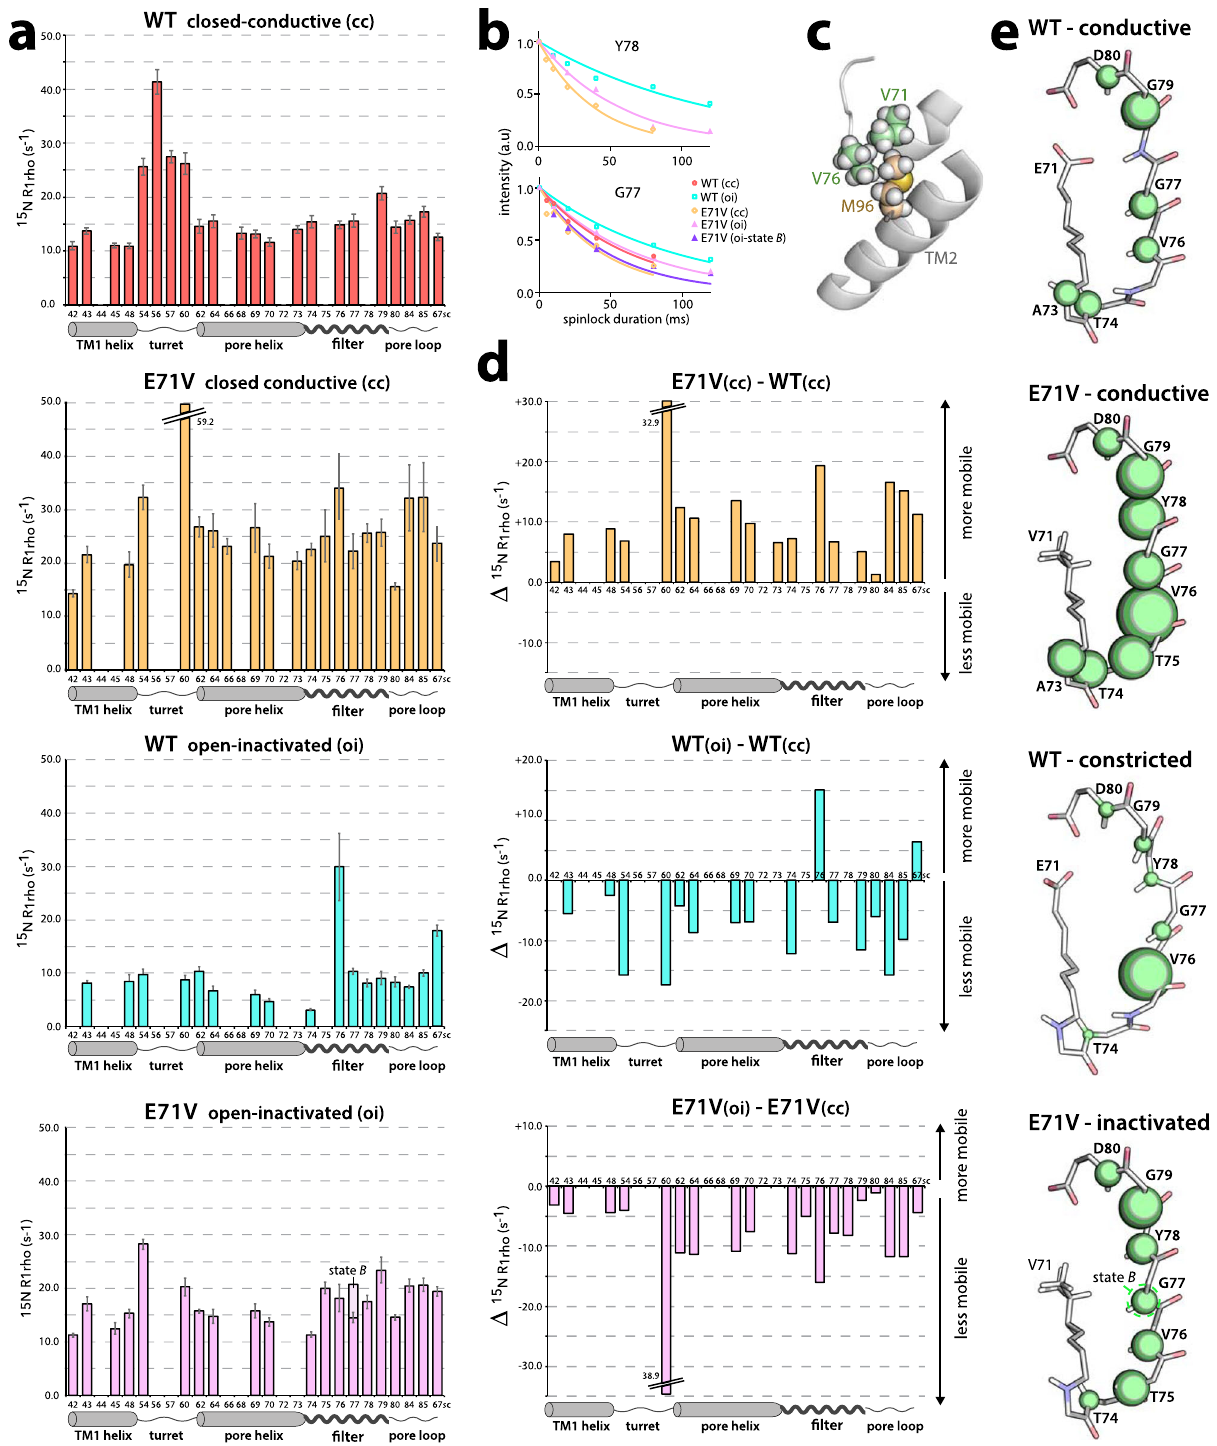
Fig. 6 Dynamics measurements in different gating modes. a 15 N rotating-frame ssNMR relaxation rates ( R 1rho ) that report on slow molecular motions in closed-conductive (cc) and open-inactivated (oi) WT KcsA (red, cyan) and E71V (yellow, pink), measured at 700 MHz and 60 kHz MAS. The error bars show the standard error of the fi t. Source data are provided as a Source Data fi le. b R 1rho signal decay curves for selected fi lter residues. Symbols mark data points and lines represent best fi ts. c The valine behind the E71V fi lter is in direct contact with the hydrophobic V76 and M96 sidechains. d Plots of the differences in the dynamics between the closed-conductive (cc) states of E71V and WT, and for each WT and E71V the dynamics differences between their open-inactivated (oi) and closed-conductive (cc) states. Source data are provided as a Source Data fi le. e Illustration of the site-resolved selectivity fi lter dynamics. The size of the green spheres represents the R 1rho relaxation